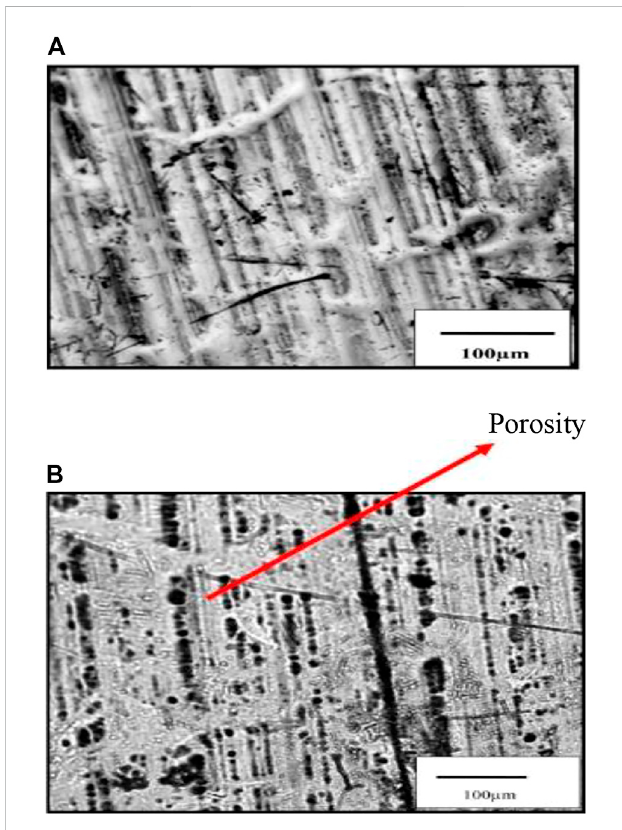
FIGURE 13 (A) Optical micrograph of the sample shows the top surface of coated steel. (B) Optical micrograph shows the top surface of coated steel having porosity.